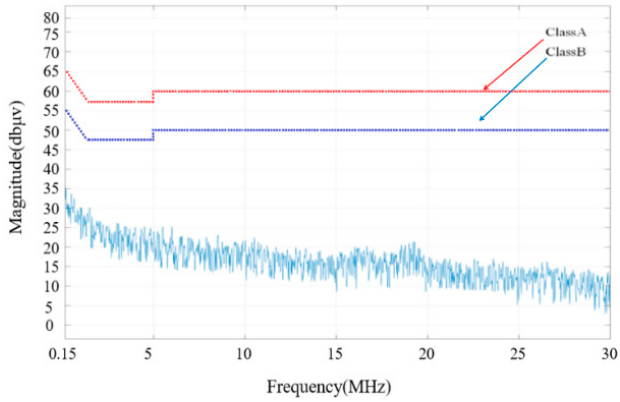
Figure 23. Simulation of CM EMI after suppression.